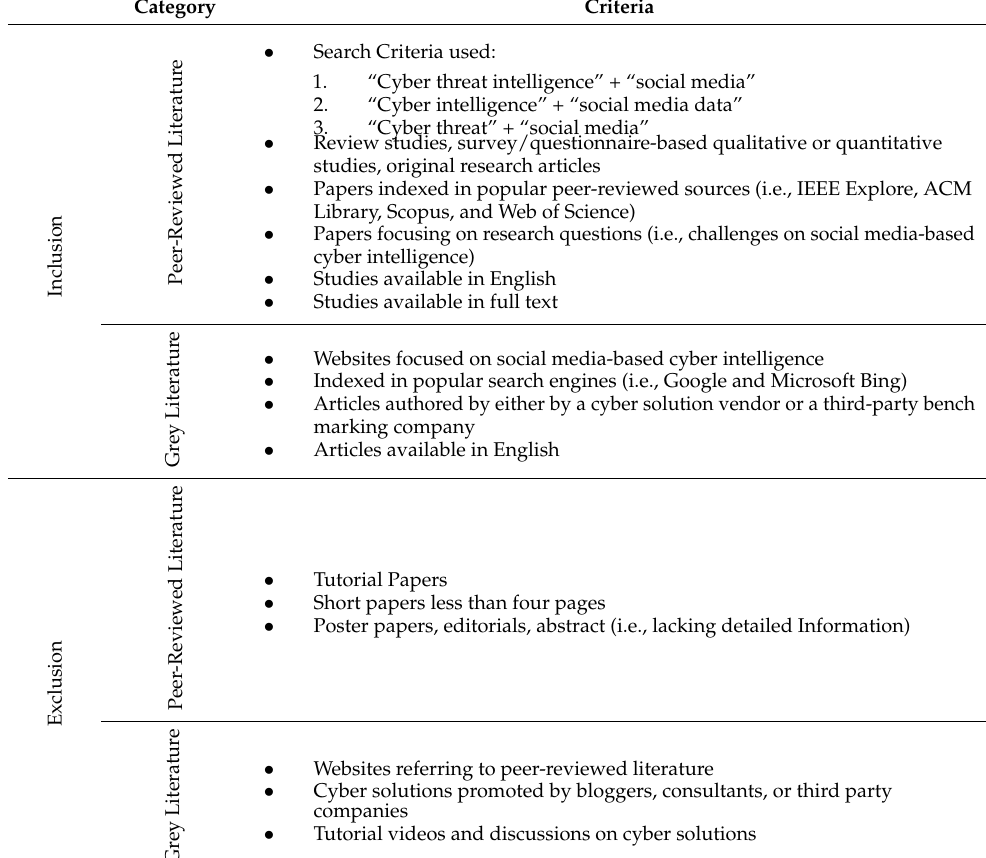
Figure 1. Overview of the design for a new cyber index system by a systematic literature review, finding challenges, developing requirements, and finally, designing the solution. Table 1. Inclusion and exclusion criteria for both peer-reviewed and grey